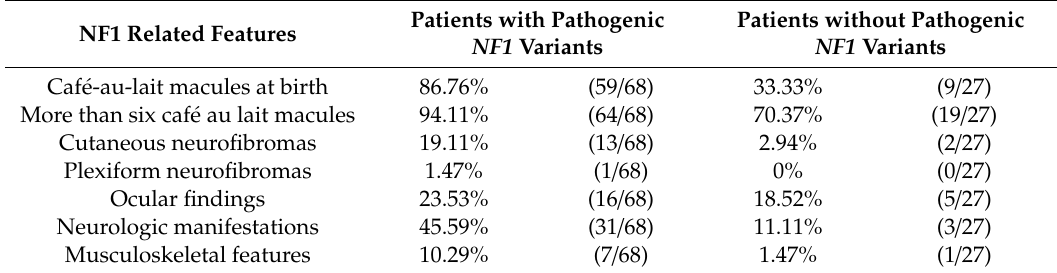
Table 2. Clinical profile of patients with or without pathogenic NF1